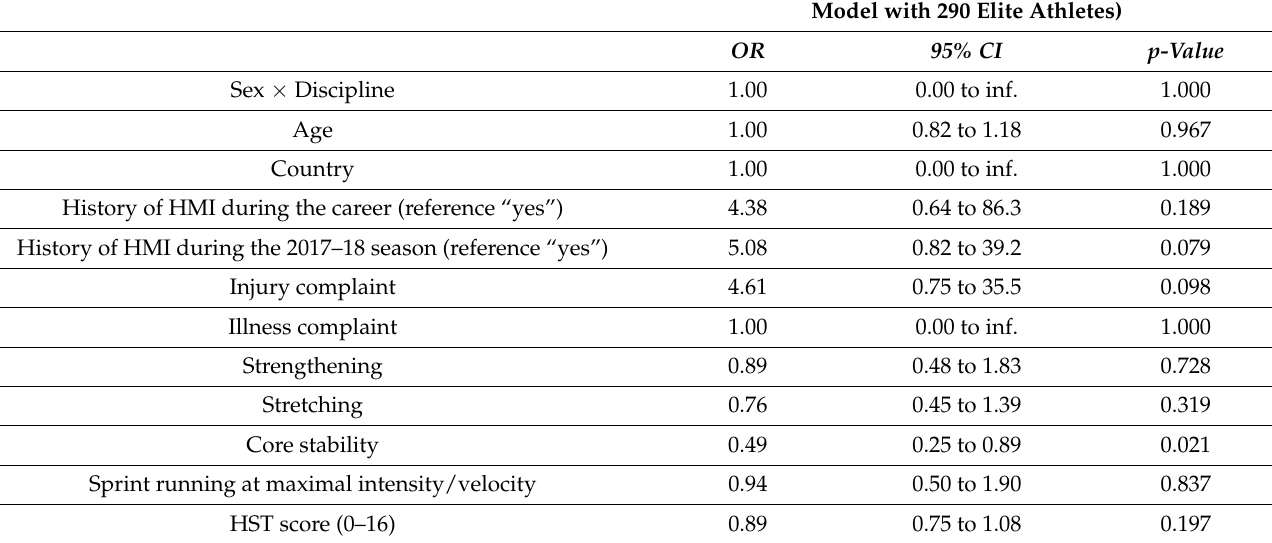
Table 3. Risk indicators for sustaining an in-championships hamstring muscle injury (HMI) presented as Odd Ratios (OR) with 95% confidence intervals (95% CI) calculated by univariate logistic regression analysis ( n = 290). In-Championships Hamstring Muscle Injury (Univariate Model with 290 Elite